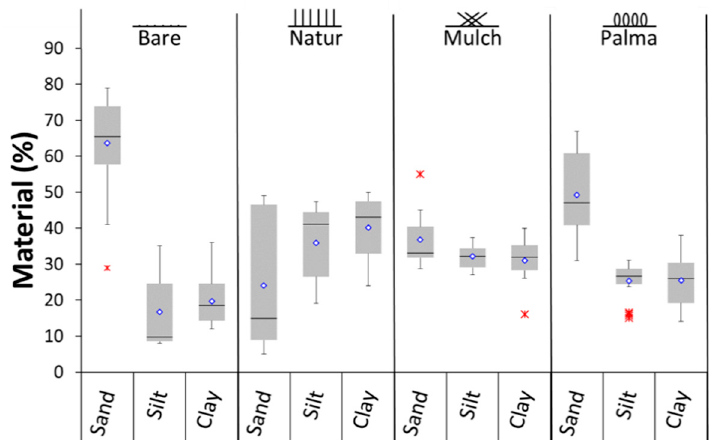
Figure 10. Boxplot of the percentages of sand, silt, and clay for sediments transported in runoff, for all plot covers. Key: ' ◊ ' average; '-' median; ' □ ' 25% to 75% probability; ' ┬ ' maximum; ' ┴ 'minimum; '*' outlier; and '°' extreme.